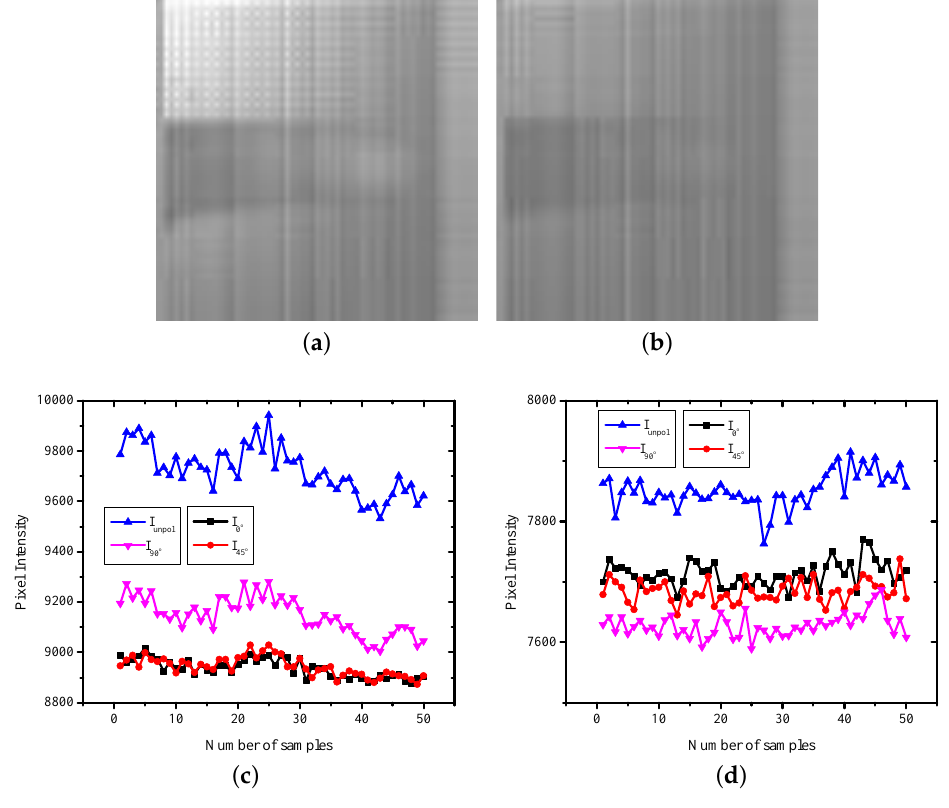
Figure 5. Sample images captured and the intensity variation of pixels with varying transmission axes over time in a resting state, with the incident light being ( a , c ) unpolarized or ( b , d ) linearly polarized at 45 ◦